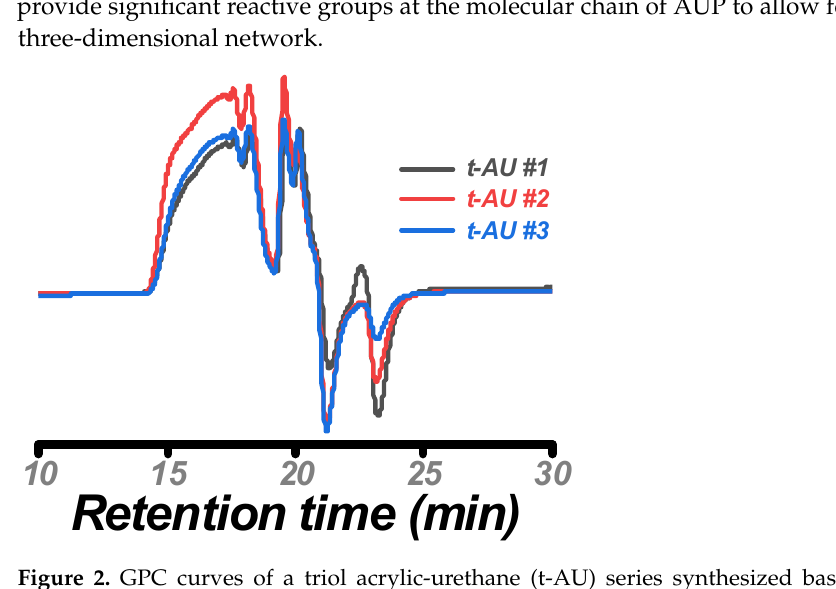
Figure 2. GPC curves of a triol acrylic-urethane (t-AU) series synthesized based on the same MW formulation. Table 2. Molecular weights and polydispersity index (PDI) of a t-AU series.